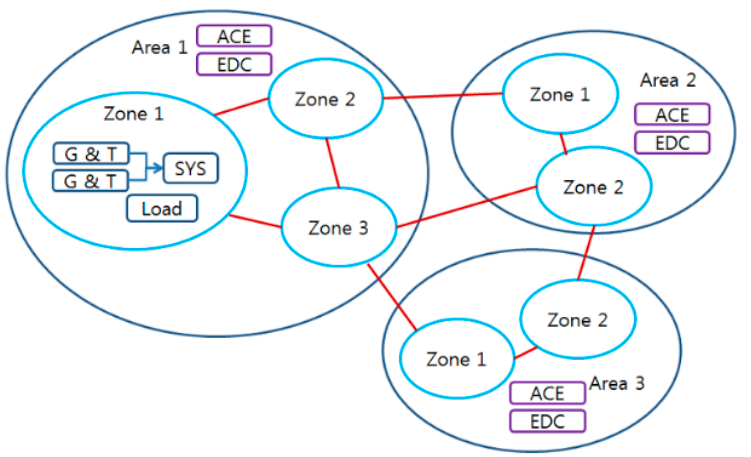
Figure 5. Block diagram of K-AGC.